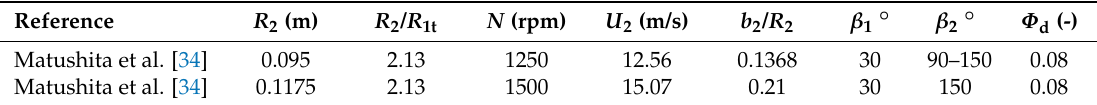
Figure 12. Example of particular pump designs using tandem blade arrangement ( a ) impeller diameter of 190mm with stator vanes; ( b ) impeller diameter of 235 mm without stator vanes (these figures have been reproduced from reference [34]). Table 4. Reference list on tandem blade arrangement.